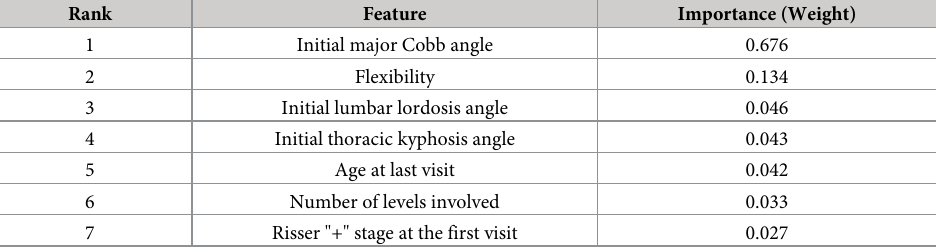
Table 7. Rank and weights of most important features to predict curve